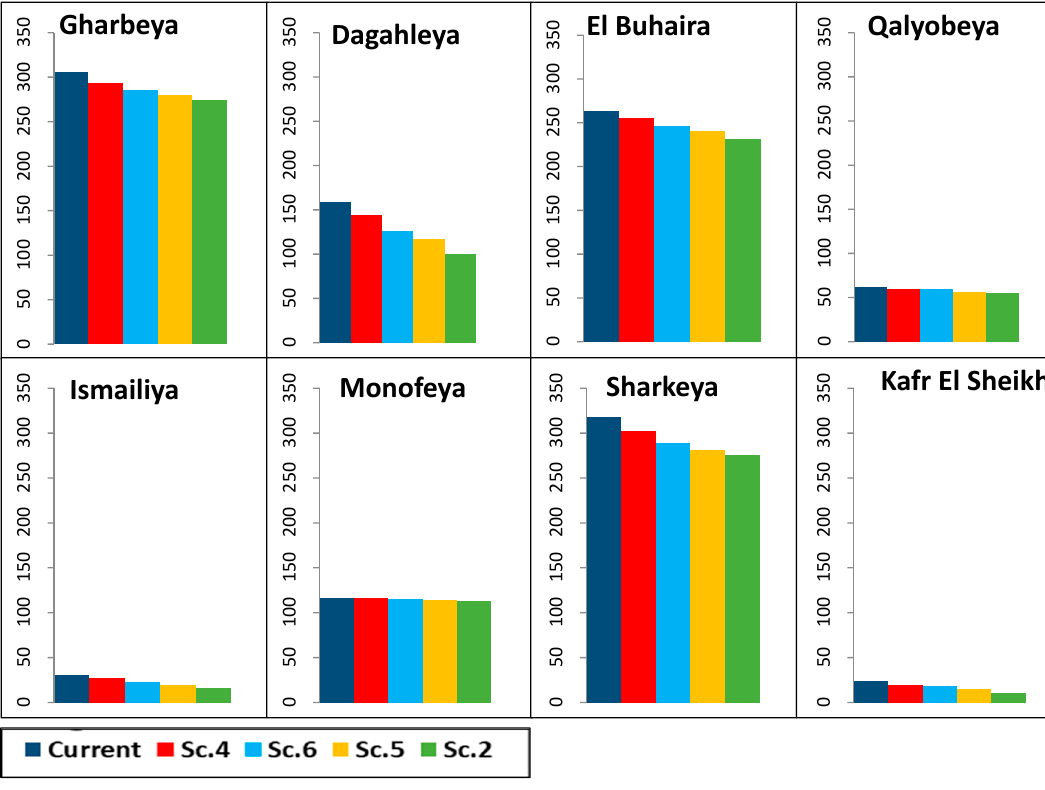
Figure 6. Block diagrams representing the fresh groundwater volume for different scenarios in selected governorates.